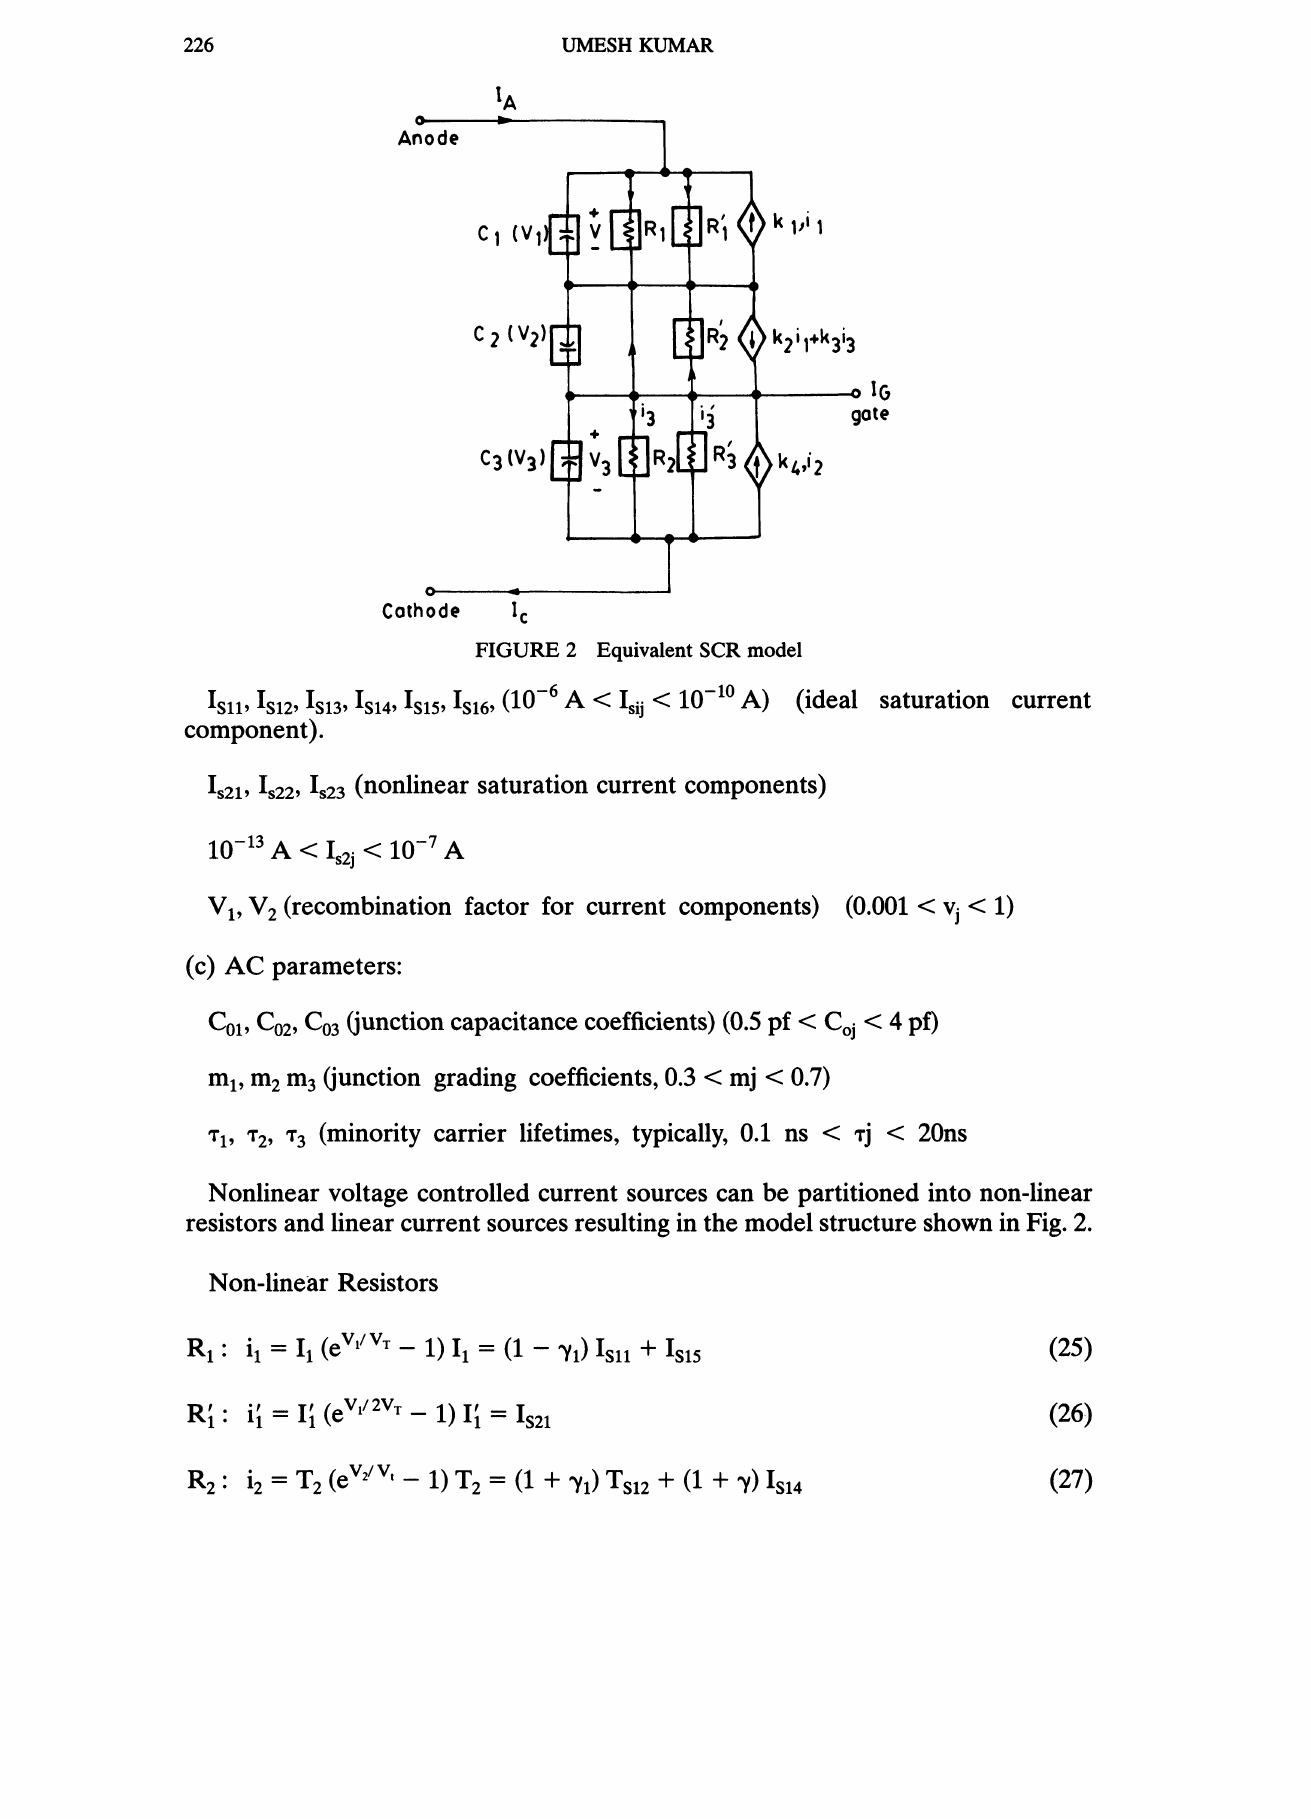
FIGURE 2 Equivalent SCR